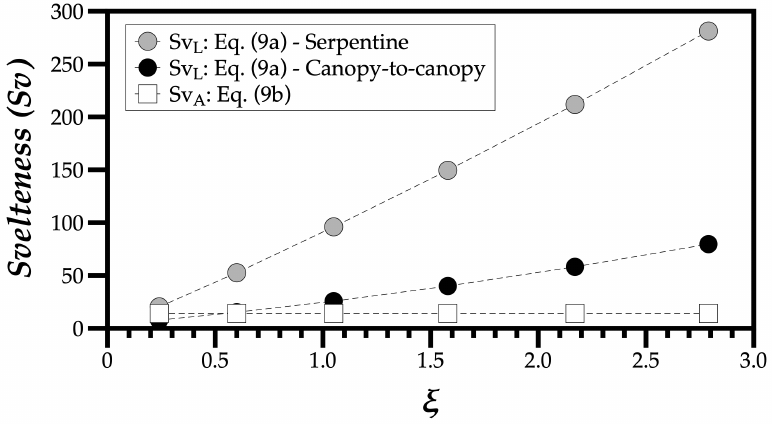
Figure 8. Flow length versus area-based